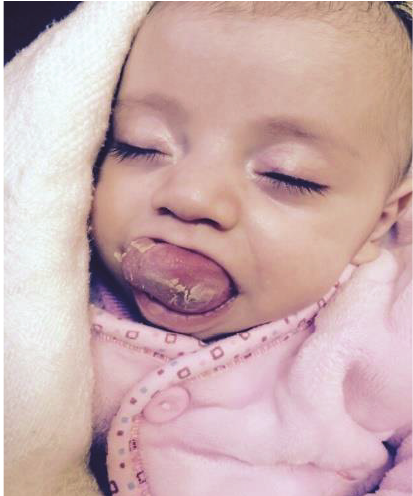
Figure 2: Recurrence of the swelling after the marsupialization.